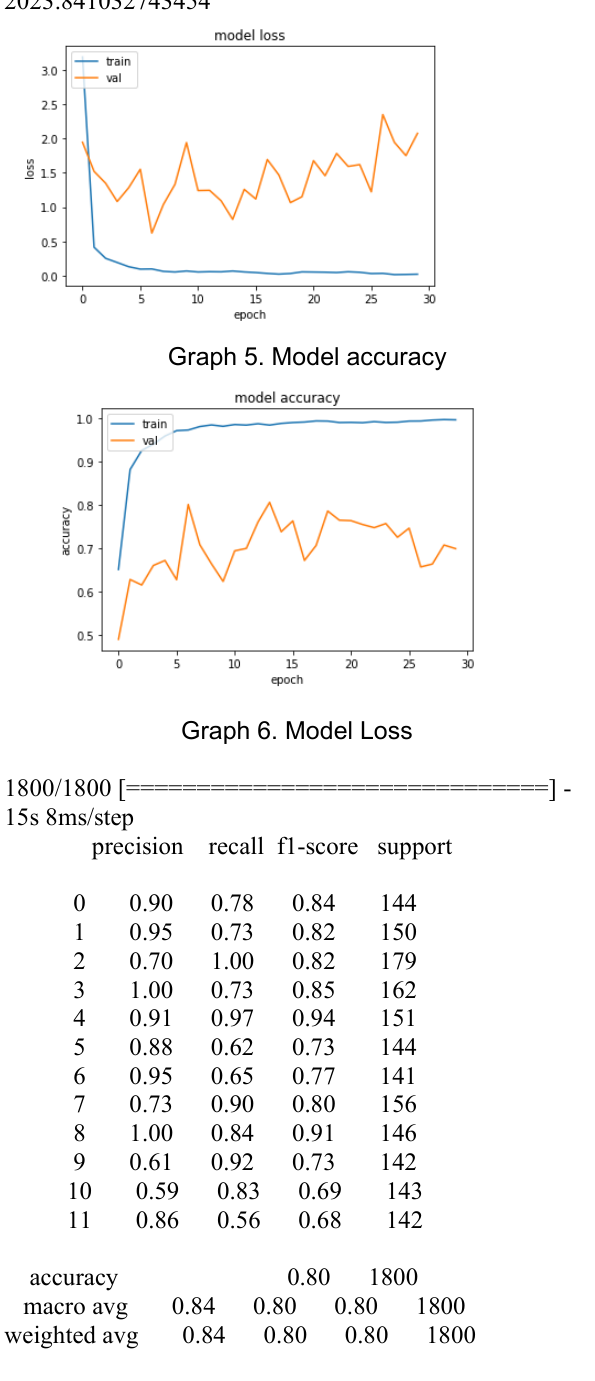
Figure 19. Confusion Matrix